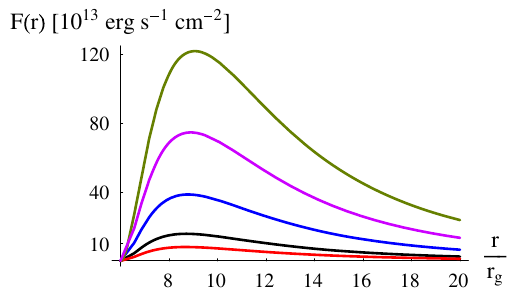
Fig. 4 Energy flux F ( r ) versus r . In these plots we took the mass of r g the WH model III (13) M = 10 6 × M (cid:9) , r 0 = kr g [2 < k < 6 (15) , c = 299792458 m/s, M (cid:9) = 1 . 9888 × 10 30 kg, and (57)], M = 4 M 2 k + 1 and accretion mass rate = 2 . 5 × 10 − 5 M (cid:9) / yr. Red Plot: Schwarzschild BH with mass M S = 10 6 × M (cid:9) . Black Plot: WH model III with k = 2 . 03. Blue Plot: WH model III with k = 3. Purple Plot: WH model III with k = 4. Green Plot: WH model III with k =